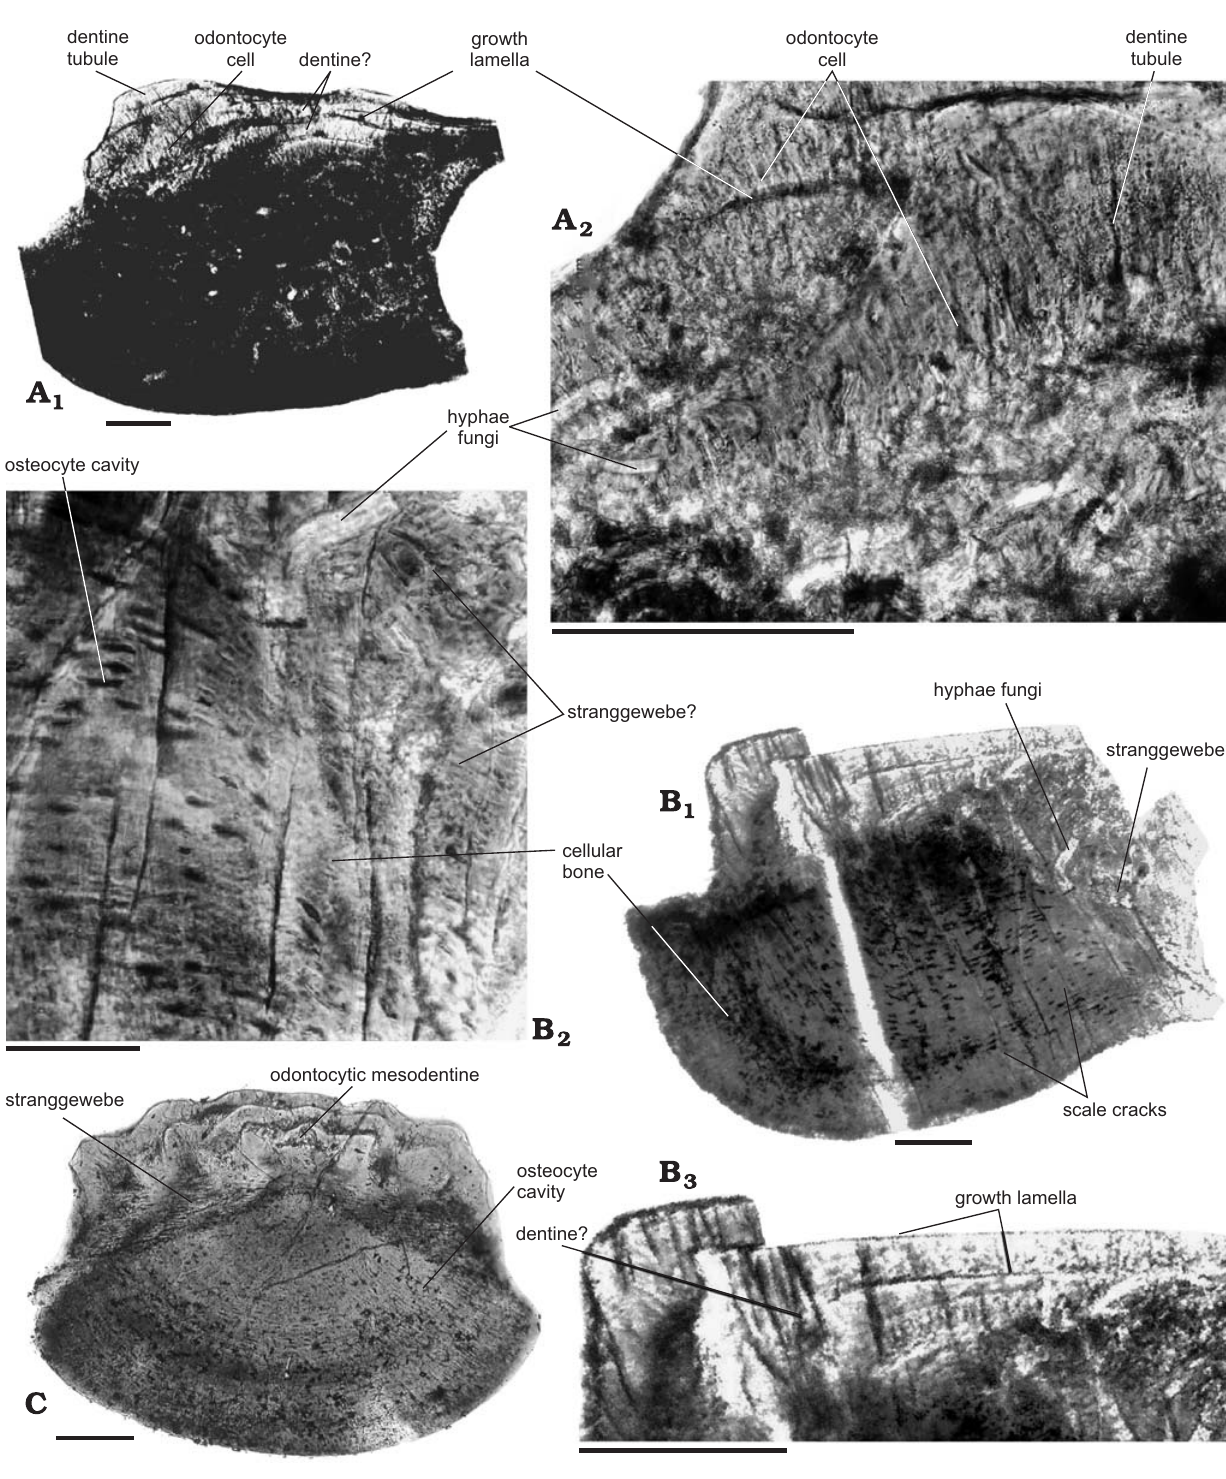
Fig. 6. Climatiid acanthodian Nostolepis sp. cf. N. gaujensis Valiukevičius, 1998 from early Frasnian, horizon GI4 of an unnamed formation in the Chahriseh section, Kaftari Mt., central Iran. Photomicrographs of thin sections of flank scales. Vertical longitudinal sections ( A , B ) and vertical transverse section ( C ) of the central part of scales. A . Thin section LIGG 3795. A 1 , structure of ?orthodentine in the outer layers and odontocytic mesodentine in the in− ner parts of growth lamellae in crown anteriorly (left part); A 2 , magnified area of the anterior crown part exposing unipolar, more outwardly−oriented dentine tubules emanating from large, rounded odontocytes. B . Thin section LIGG 3796. B 1 , scale exposing cellular bone in base, portions of ?orthodentine and stranggewebe tissues respectively in the anterior and posterior crown parts; B 2 , orientation of elongated osteocyte cells along the growth lines in the apex of base, and probably stranggewebe at the base/crown junction, at higher magnification; B 3 , magnified part of the anterior crown with the ortho− dentine−like tissue. C . Thin section EUIV 412 showing a dense lamellarity of cellular bone in scale base with plenty of osteocytes, stranggewebe in the lower crown, and partly bush−like odontocytic mesodentine in the outer parts of growth zones in crown. Scale bars 0.1